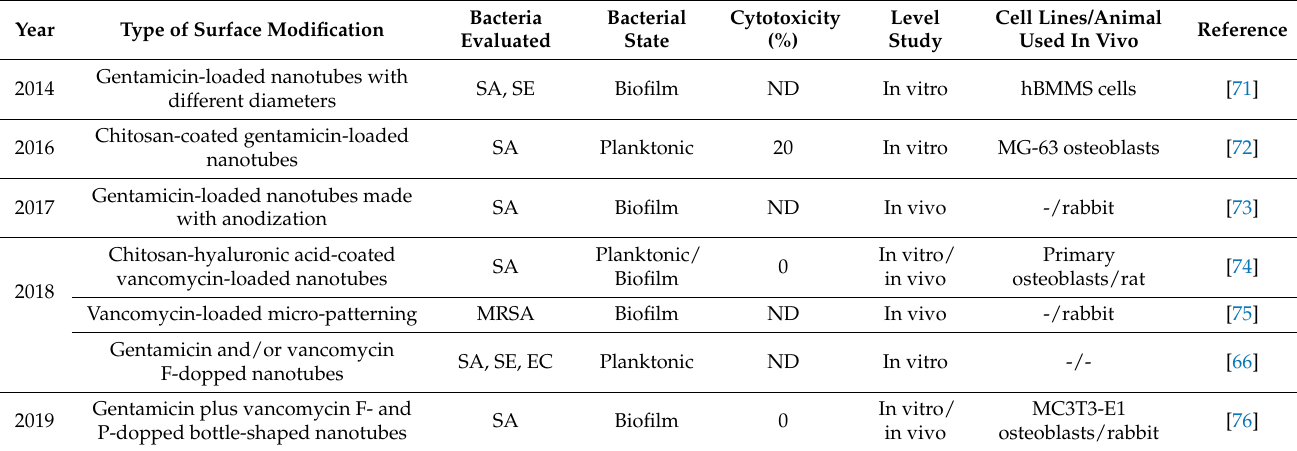
Table 1. Some of the most relevant studies based on titanium nanotubes loaded with